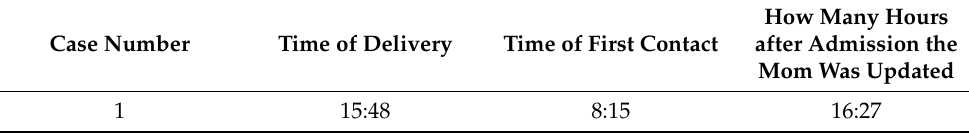
Table 1. Summary of the Update